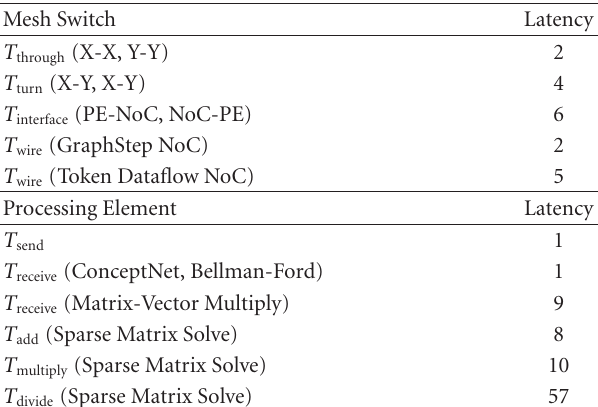
Table 2: NoC timing